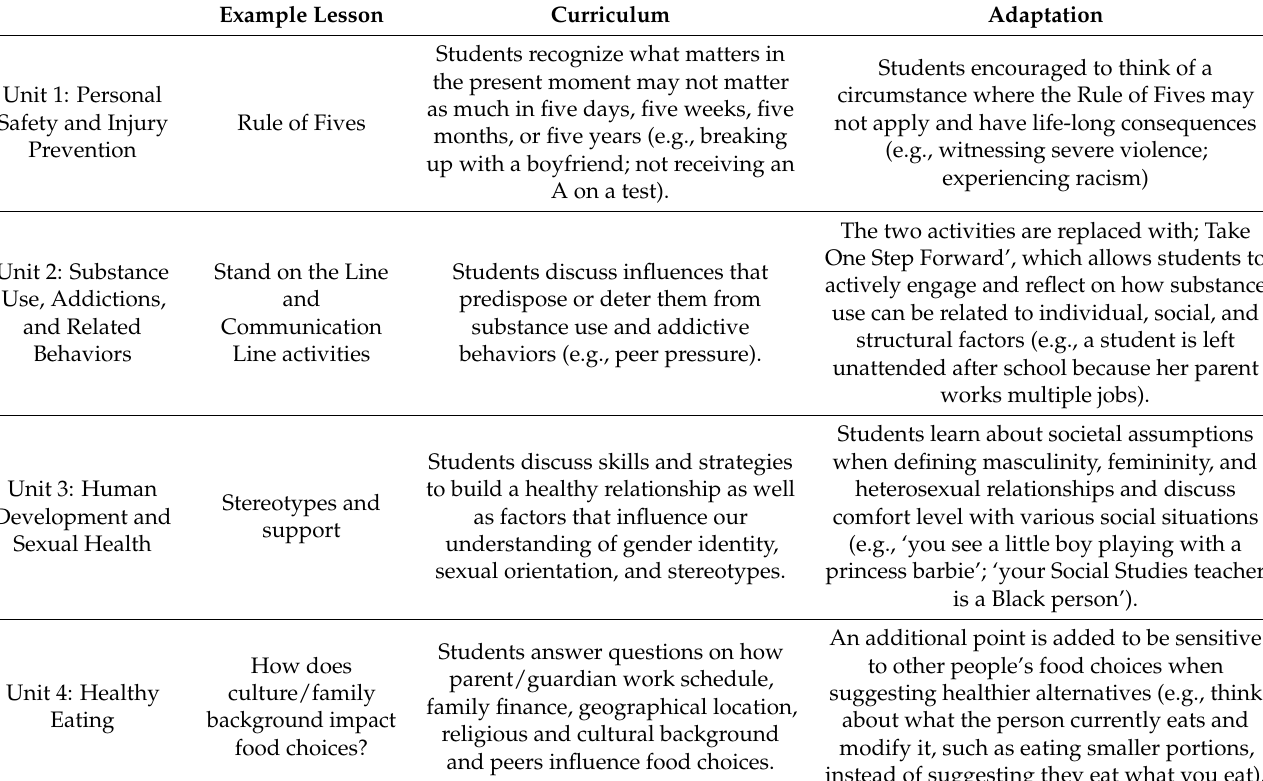
Table 1. Augmented Fourth R